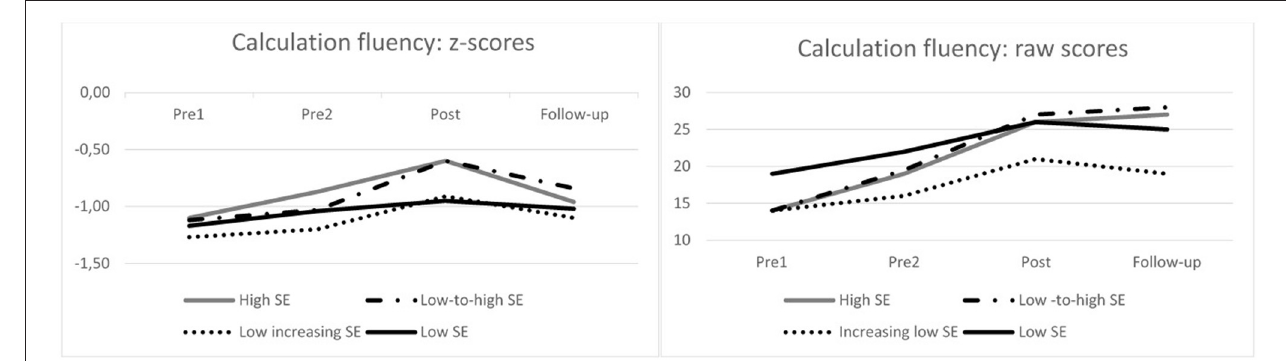
FIGURE 1 | Development of calculation fluency among children with different SE-profile.